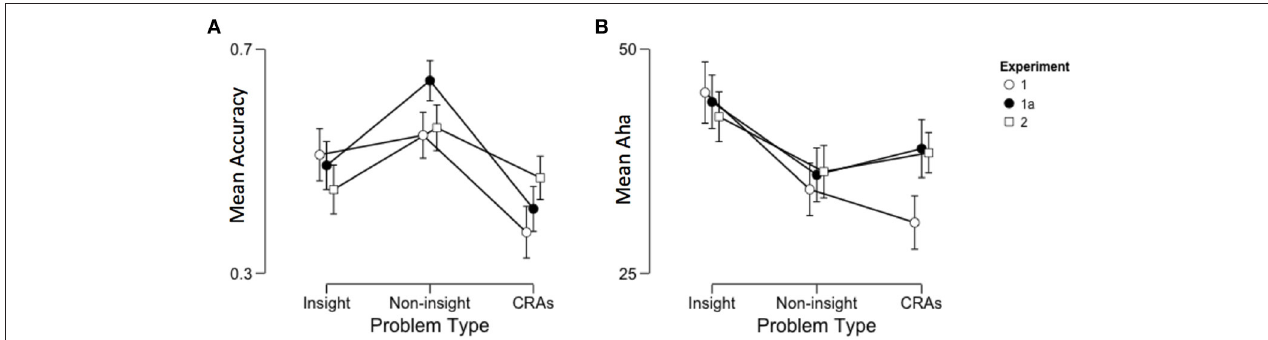
FIGURE 1 | Mean (A) accuracy and (B) reported insight across problem types, with separate lines representing the different experiments (Experiments 1a and 2 have participants are filtered for ESL students). Error bars are 95% confidence intervals.